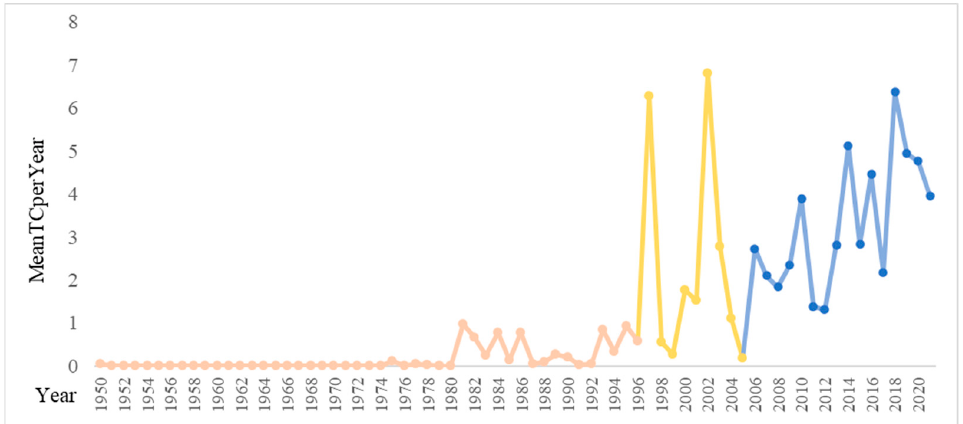
Figure 5. Average number of citations per year in land consolidation and rural revitalization from 1950 to 2021.